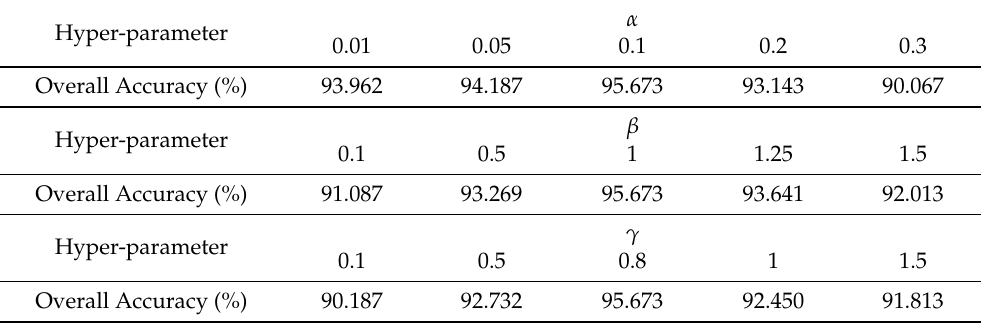
Table 6. Impact of hyper-parameters α , β , and γ on the NWPU-RESISC45 dataset. We adopt ResNet- 101 as the teacher network and ResNet-34 as the student